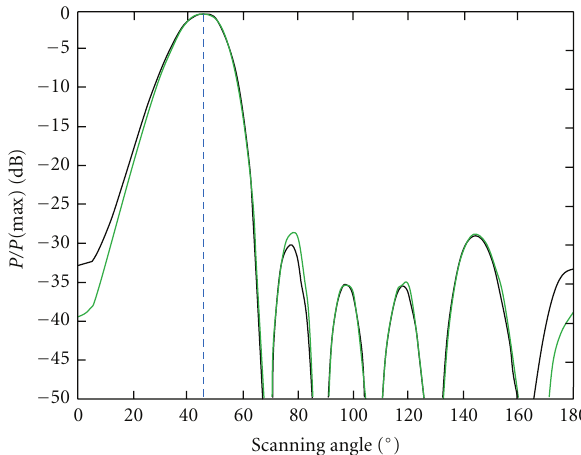
Figure 14: The beam pattern pointed towards the useful signal with the angle 45